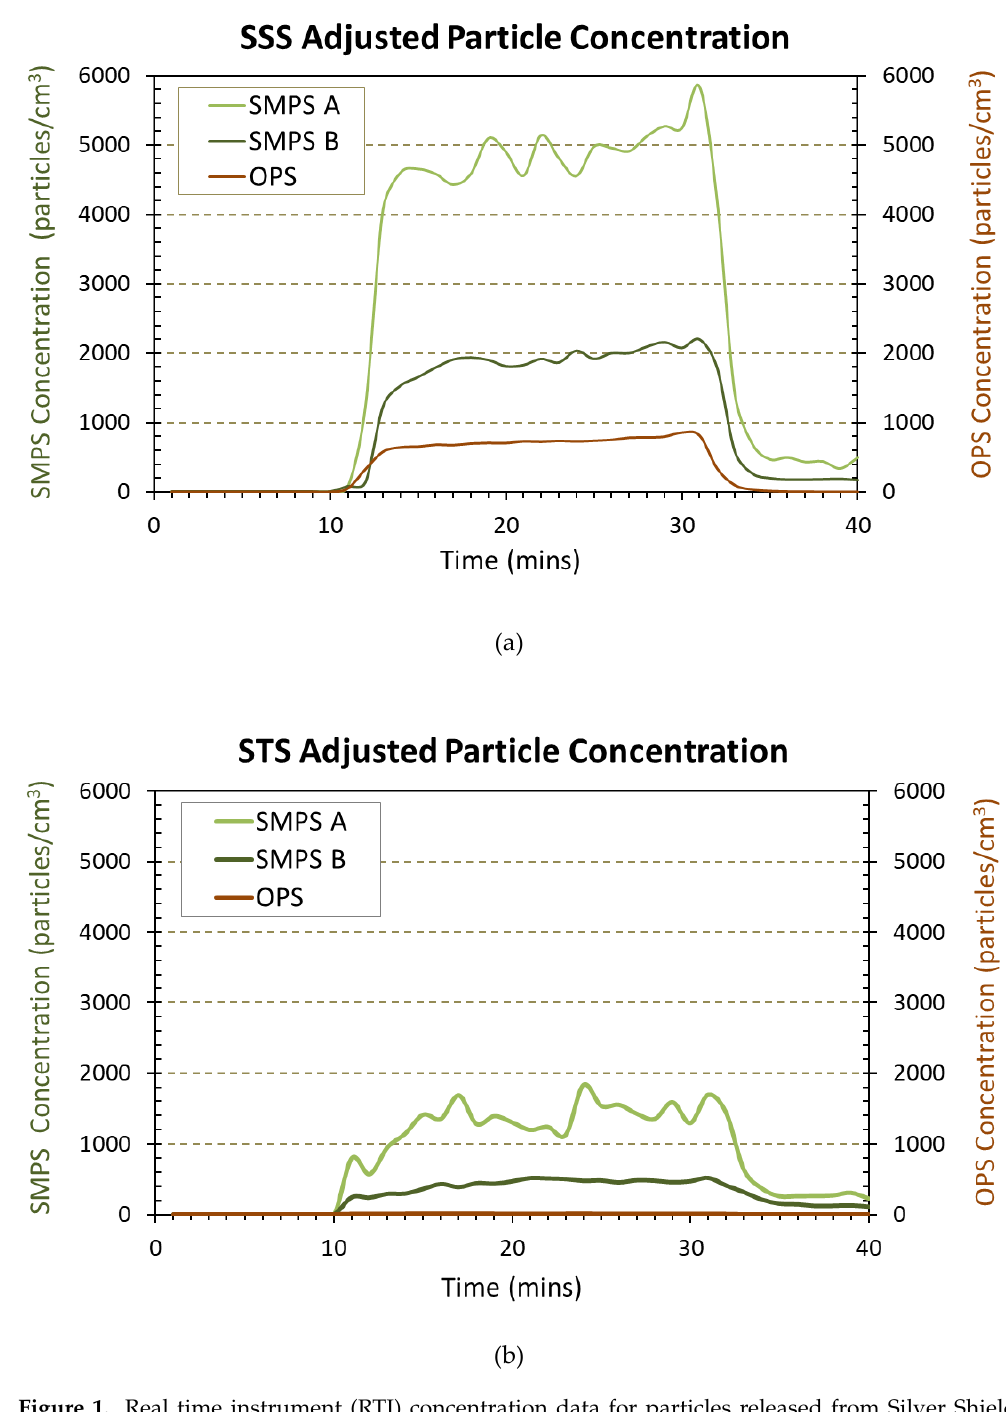
Figure 1. Real time instrument (RTI) concentration data for particles released from Silver Shield Sanitizer (SSS) ( a ) and Silver Throat Spray (STS) ( b ).